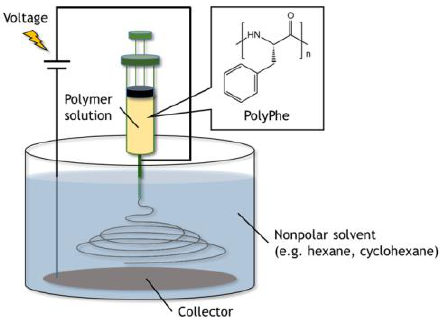
Figure 1. The experimental setup for electrospinning used in this study. All processes including spinning were done in a nonpolar solvent.